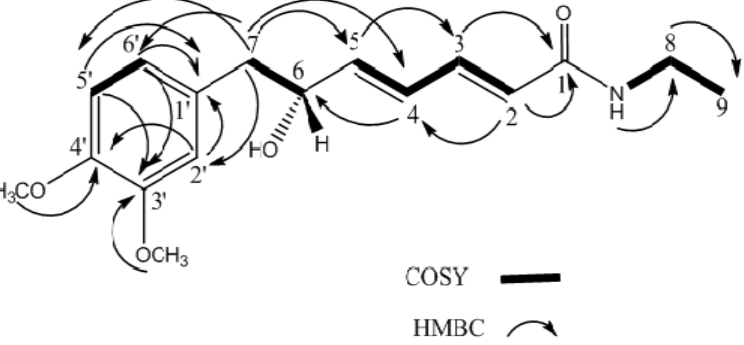
Figure 2. Selected 2D-NMR (HMBC and COSY) correlations of (-)-kunstleramide( 1 ).